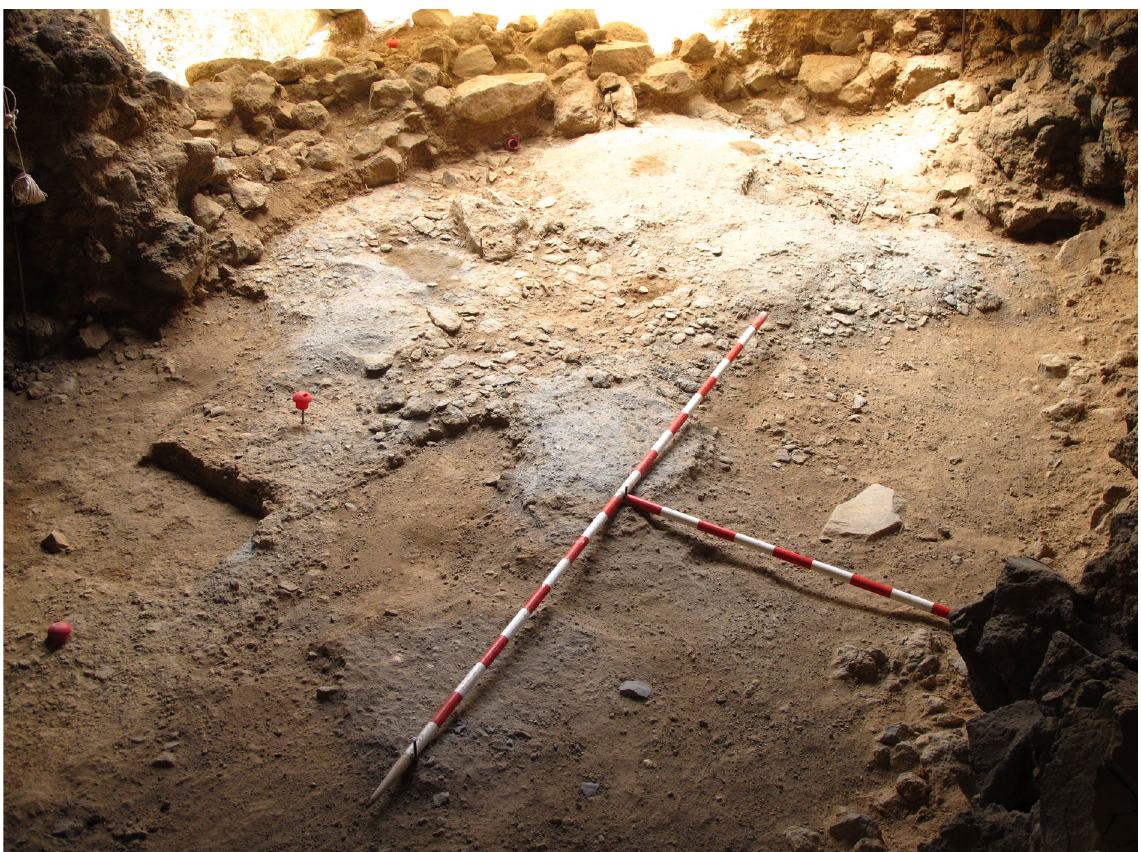
Figure 1. View of the Barranco Cardones rotary quern workshop (Cave 36, Arucas, Gran Canaria).